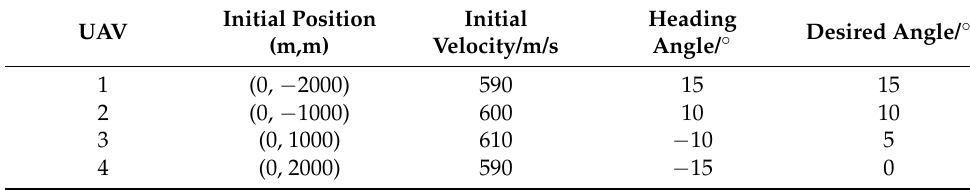
Table 1. Initial conditions of multiple